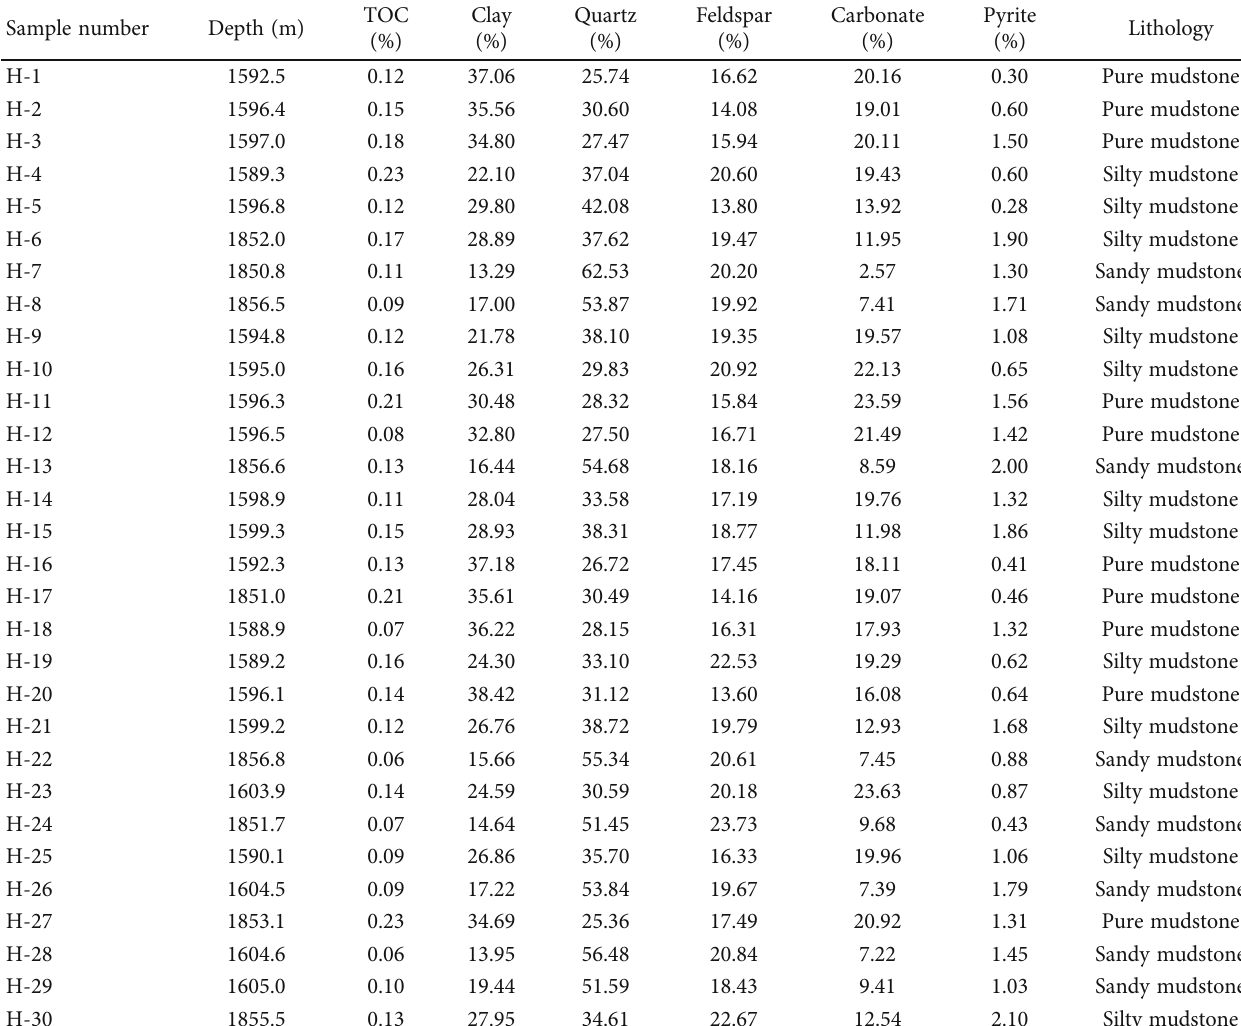
Table 1: TOC and mineral content of Quaternary mudstone